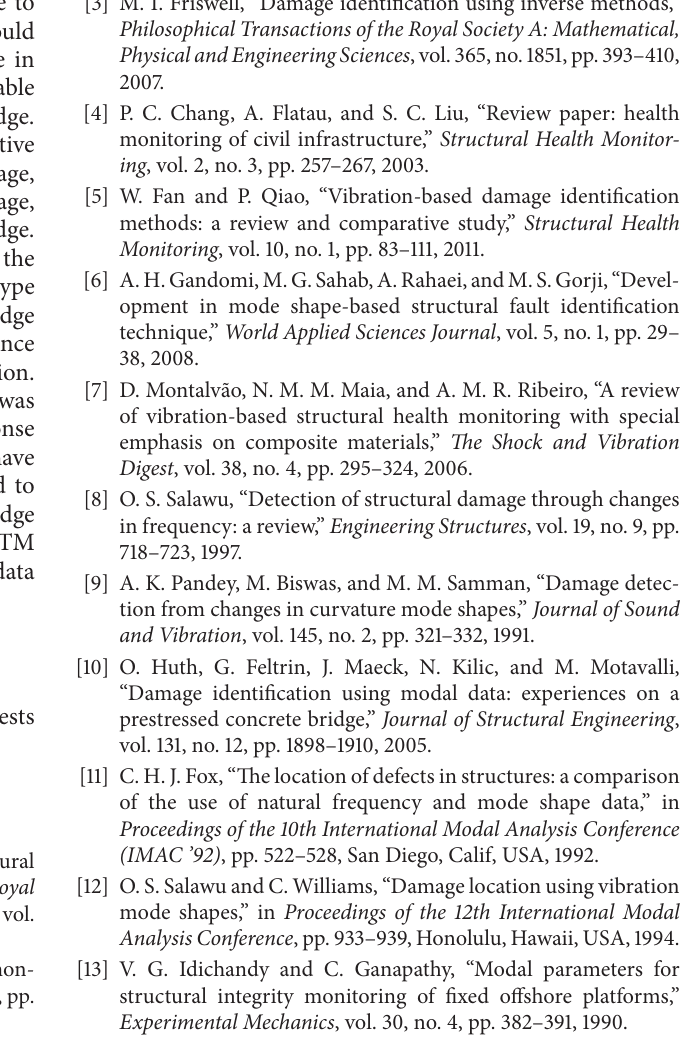
for damage case curv